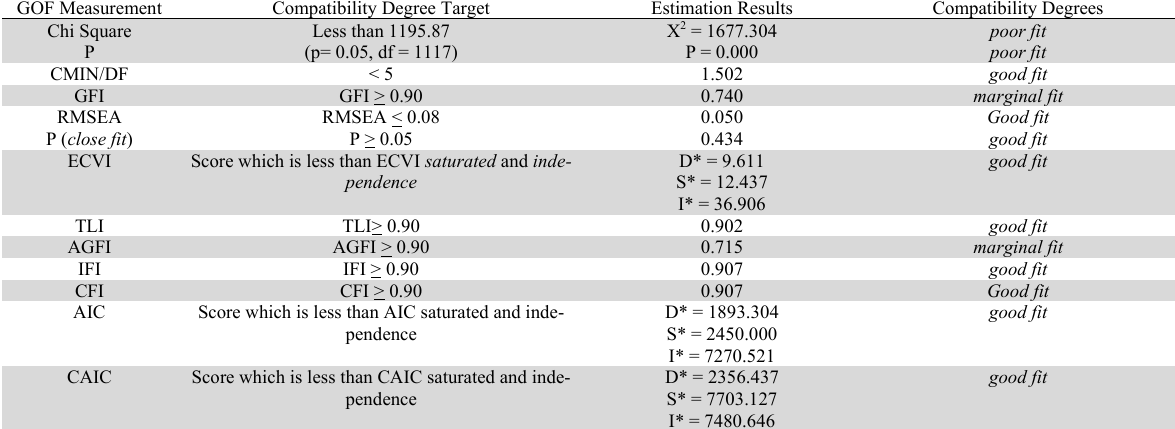
The Results of Goodness of Fit (GOF) Testing and Compatibility Degrees of Confirmation Factor Analysis GOF Measurement